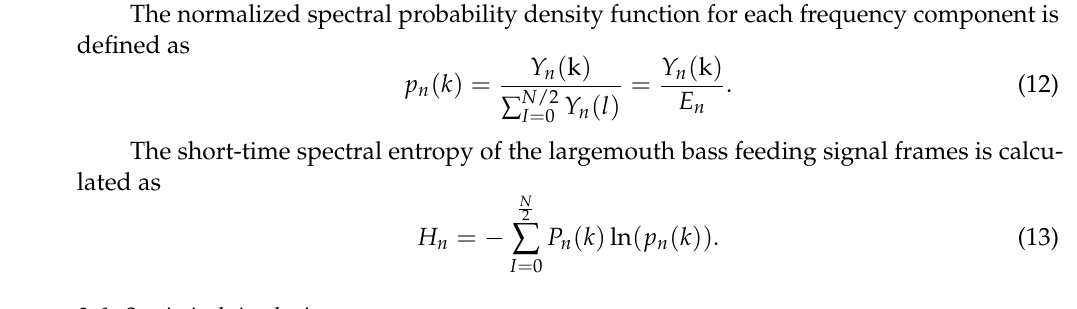
including the feeding sound vocalization frequency range of the largemouth bass and the main peak frequency found with the power spectrum and statistical analysis. Table 2 shows the statistical characteristics of the power spectra of the largemouth bass with different culture densities. Table 2. Statistical characteristic values of power spectrum of largemouth bass at different culture densities. Breeding Density Group (Fish·m − 3 )